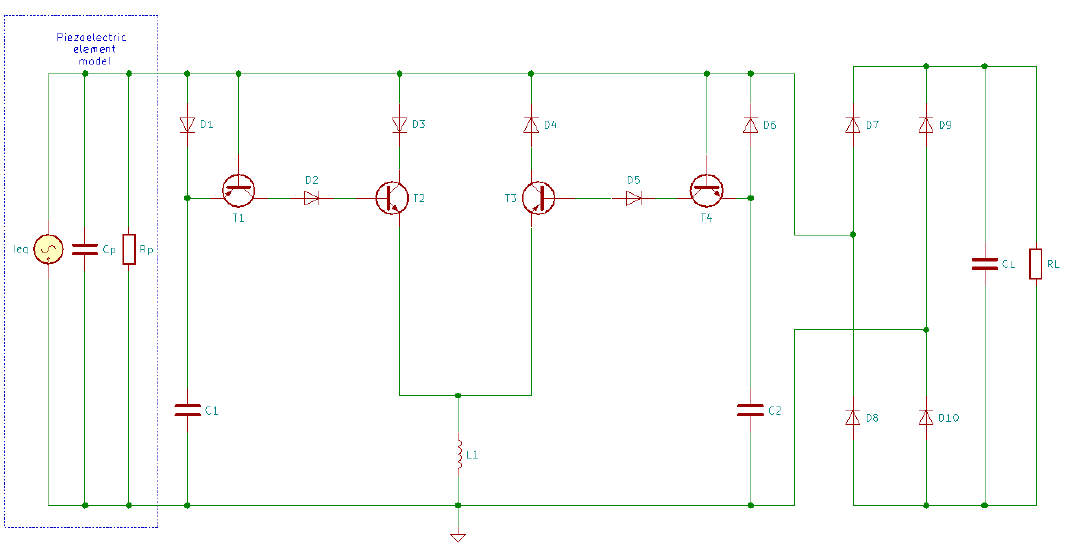
Figure 21. Self-powered parallel-SSHI energy harvesting circuit.